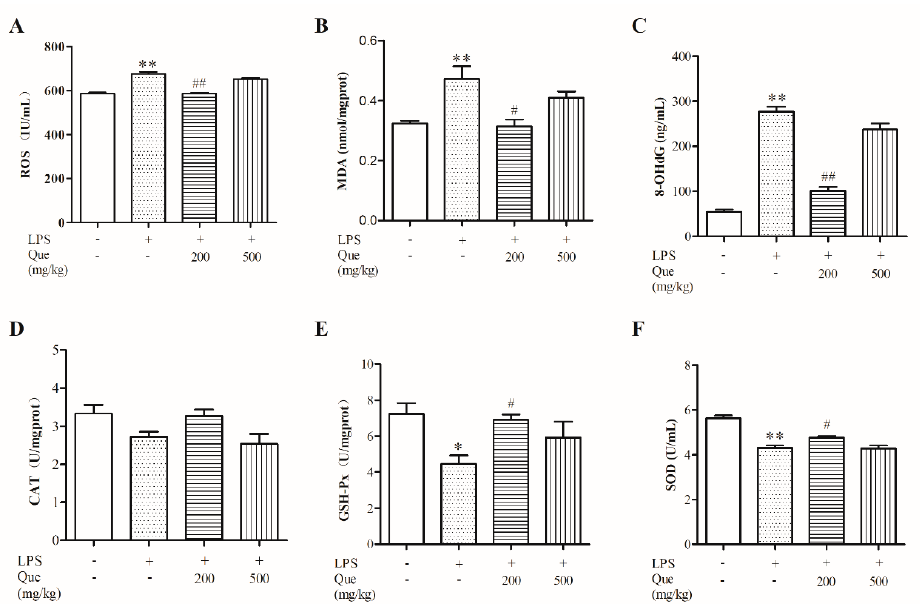
Figure 1. The effect of quercetin on oxidative stress induced by lipopolysaccharide (LPS). The levels of reactive oxygen species (ROS) ( A ), malondialdehyde (MDA) ( B ), 8-hydroxy- 2′ -deoxyguanosine (8-OHdG) ( C ), catalase (CAT) ( D ), glutathione peroxidase (GSH-Px) ( E ), and superoxide dismutase (SOD) ( F ) were measured by ELISA or chemical colorimetry (n = 6). Values are shown as the mean ± SEM. ** p < 0.01 or * p < 0.05 compared with the Con group. ## p < 0.01 or # p < 0.05 compared with the LPS group.